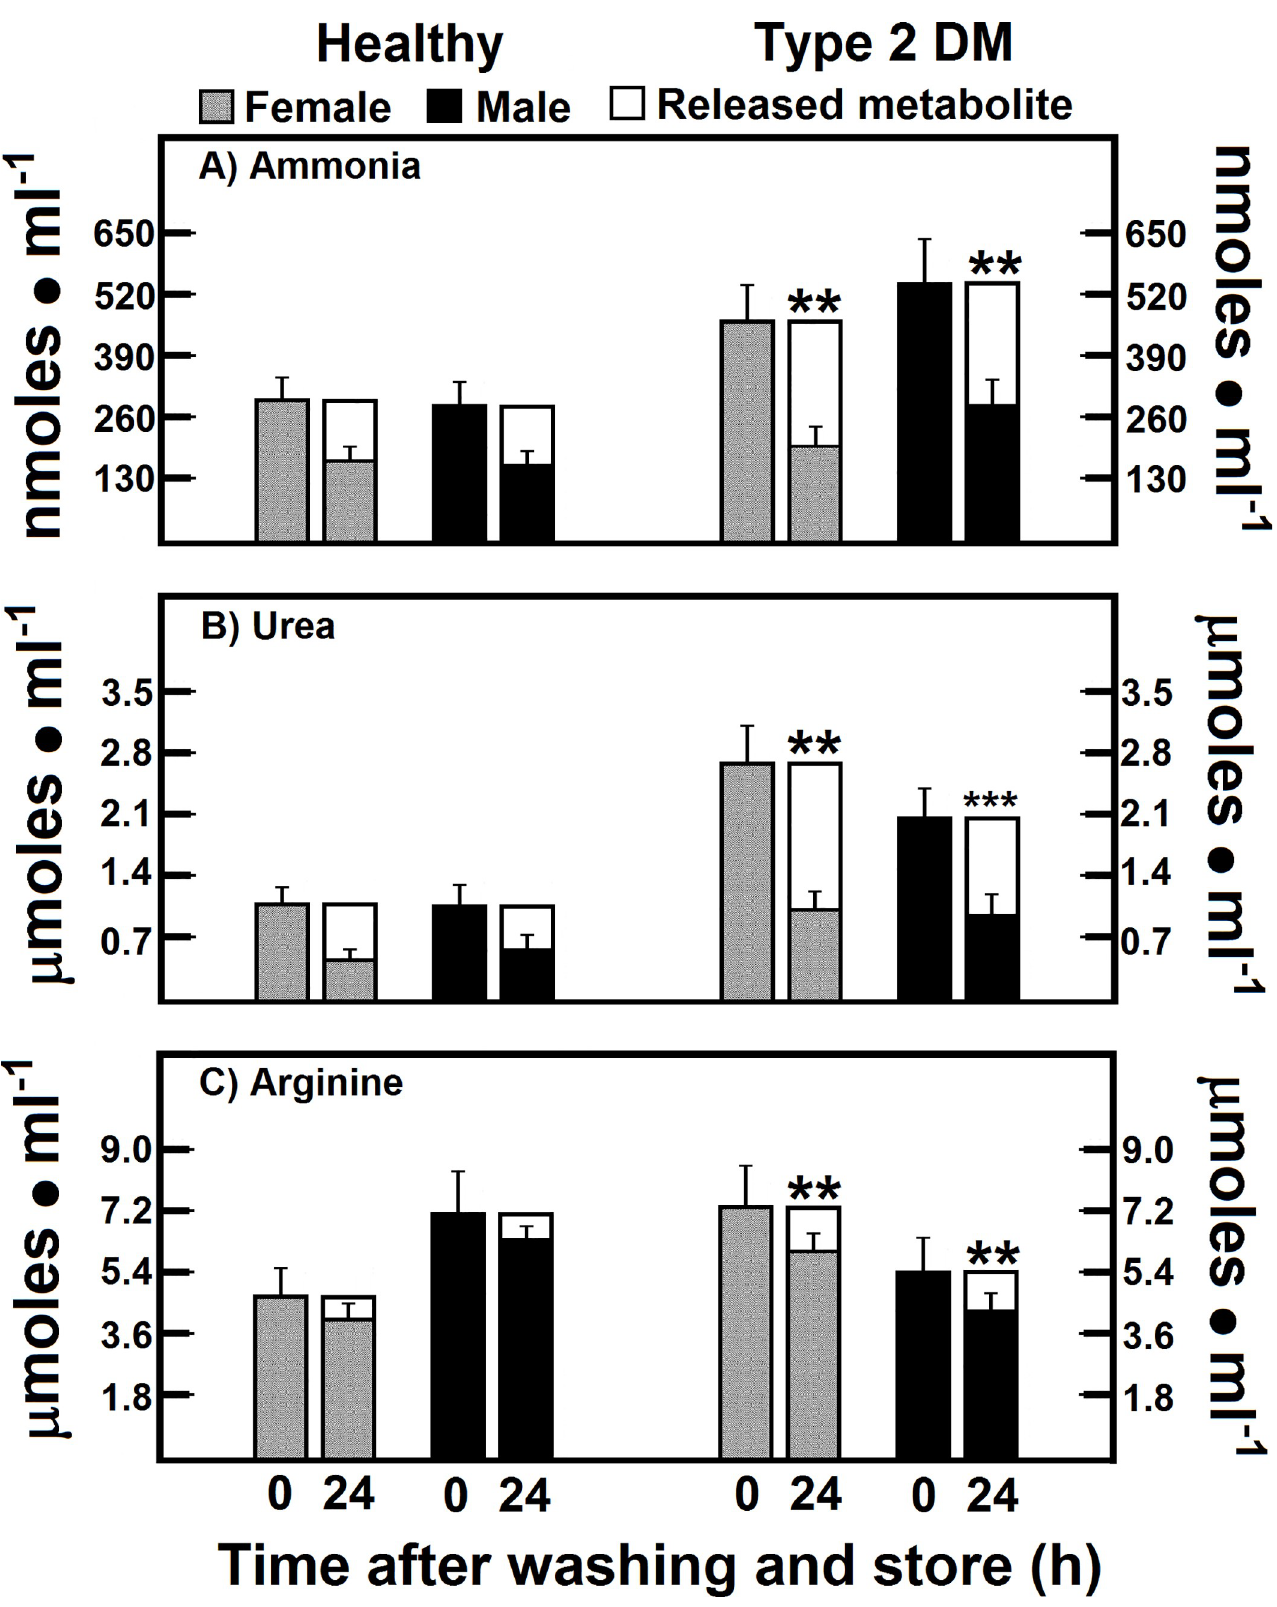
Fig 2. Release of ammonia, urea, and arginine from RBC of patients with type 2 DM after washing and storage. The results are expressed as the mean ± SD for levels of RBC ammonia, urea, and arginine, in healthy control female (n = 40) and male volunteers (n = 40), as well as in female (n = 40) and male DM type 2